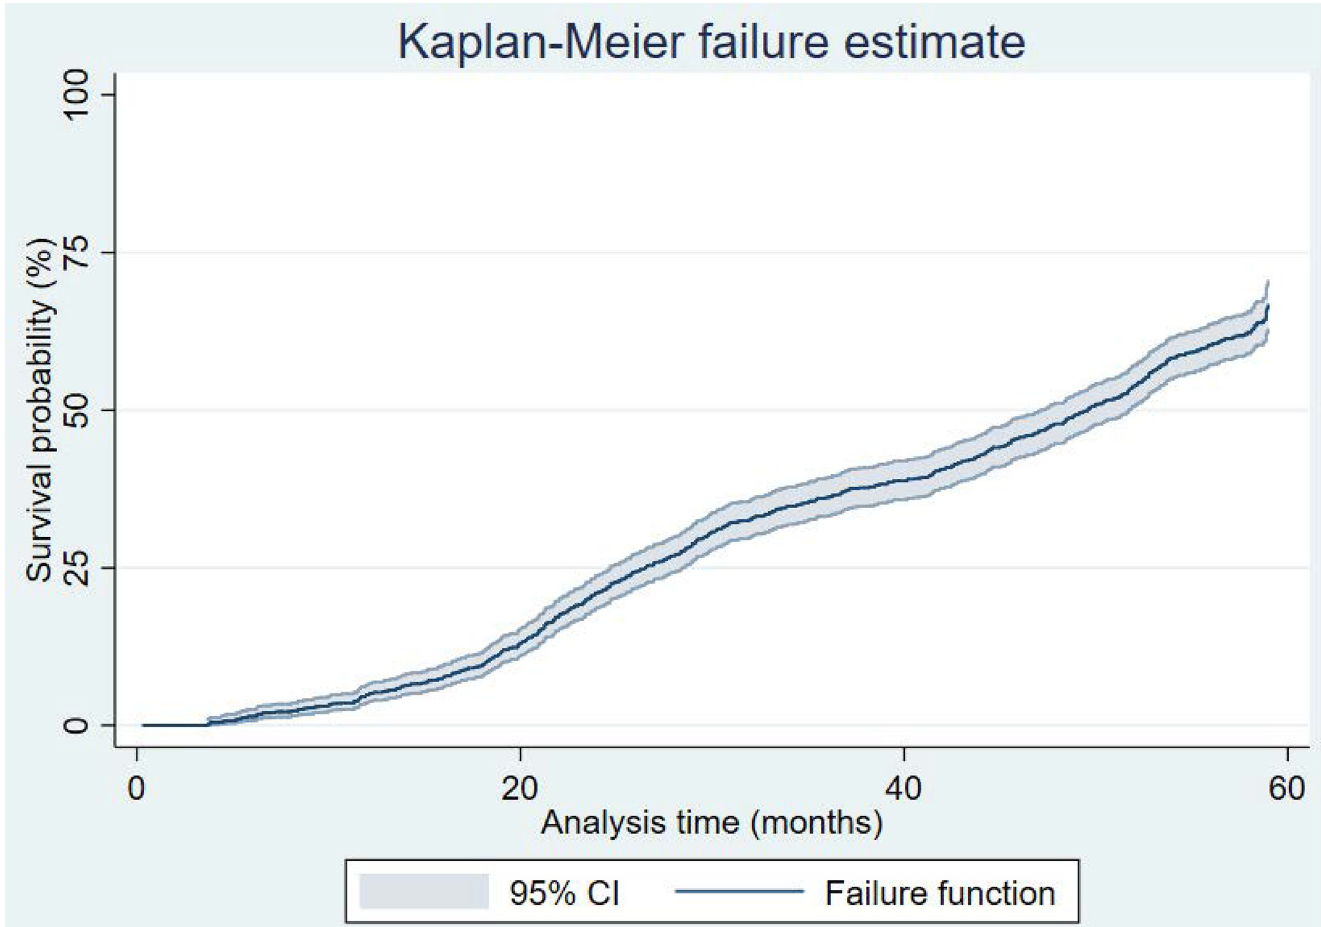
Fig 2. Kaplan-Meier recovery estimate for all stunted